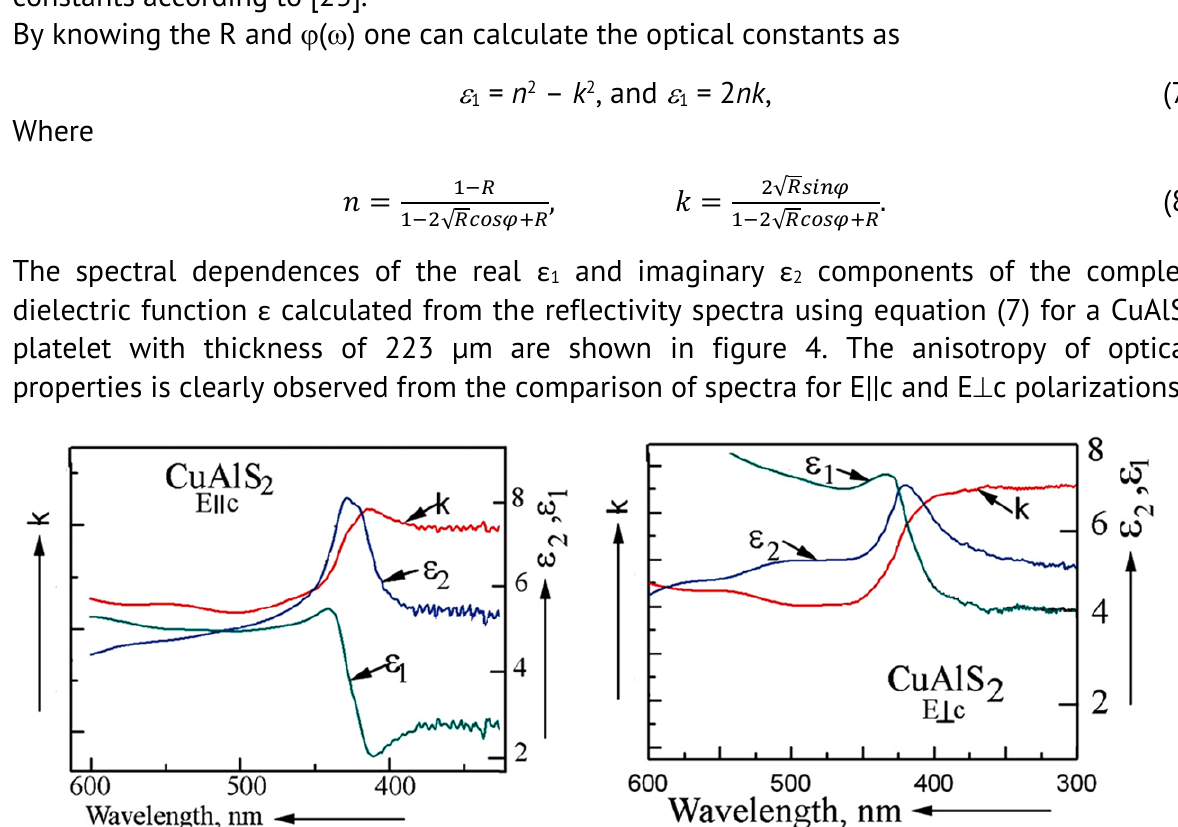
and k for polarizations E||c (left) 1 ε 2, crystals with thickness of 223 2